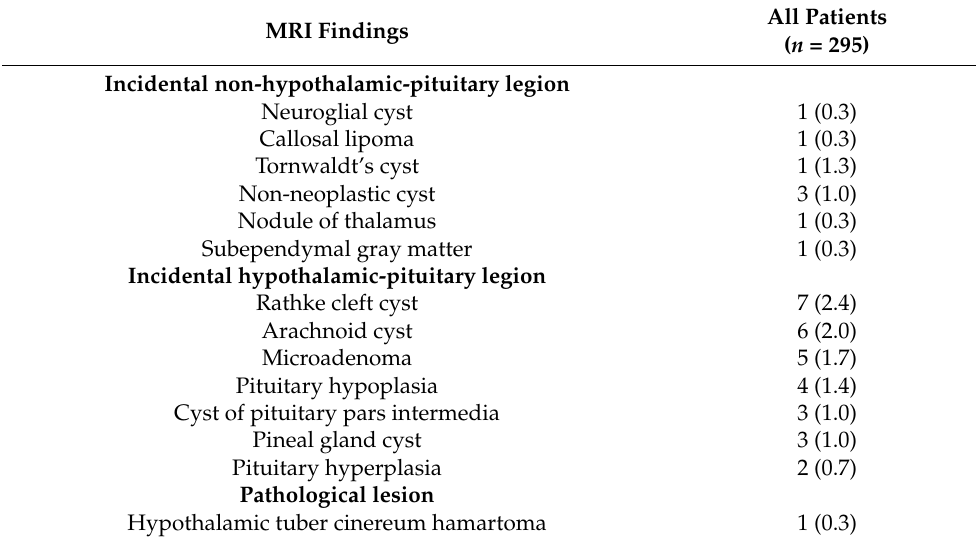
Table 1. Details of positive brain MRI findings of girls with CPP.